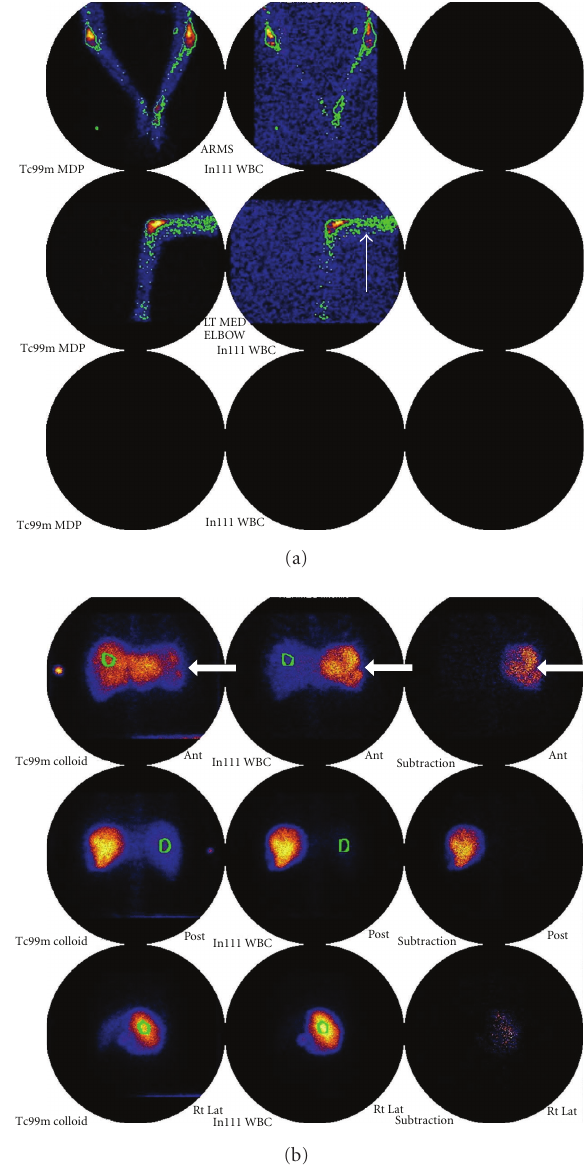
Figure 4: (a) In111 WBC and Tc99m colloid scan images in a patient with sickle cell anaemia showing abnormal increased activity in the distal left humerus on the WBC scan (white arrows) consistent with osteomyelitis. (b) Note also that multiple photopenic areas in the splenic tissue, seen on both WBC and colloid images (thick white arrows) suggest multiple splenic